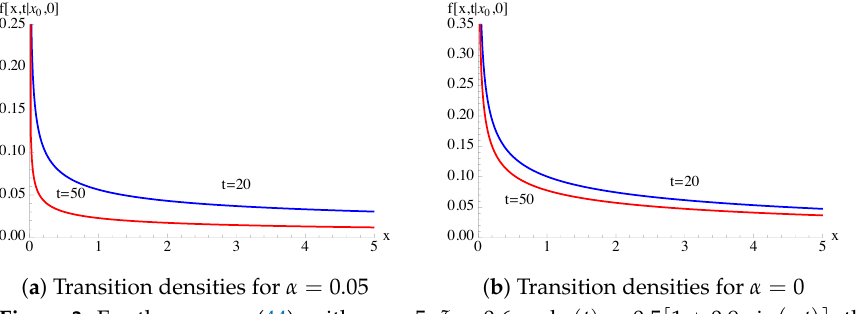
Figure 3. For the process (44), with x 0 = 5, ξ = 0.6 and r ( t ) = 0.5 densities are plotted as function of x